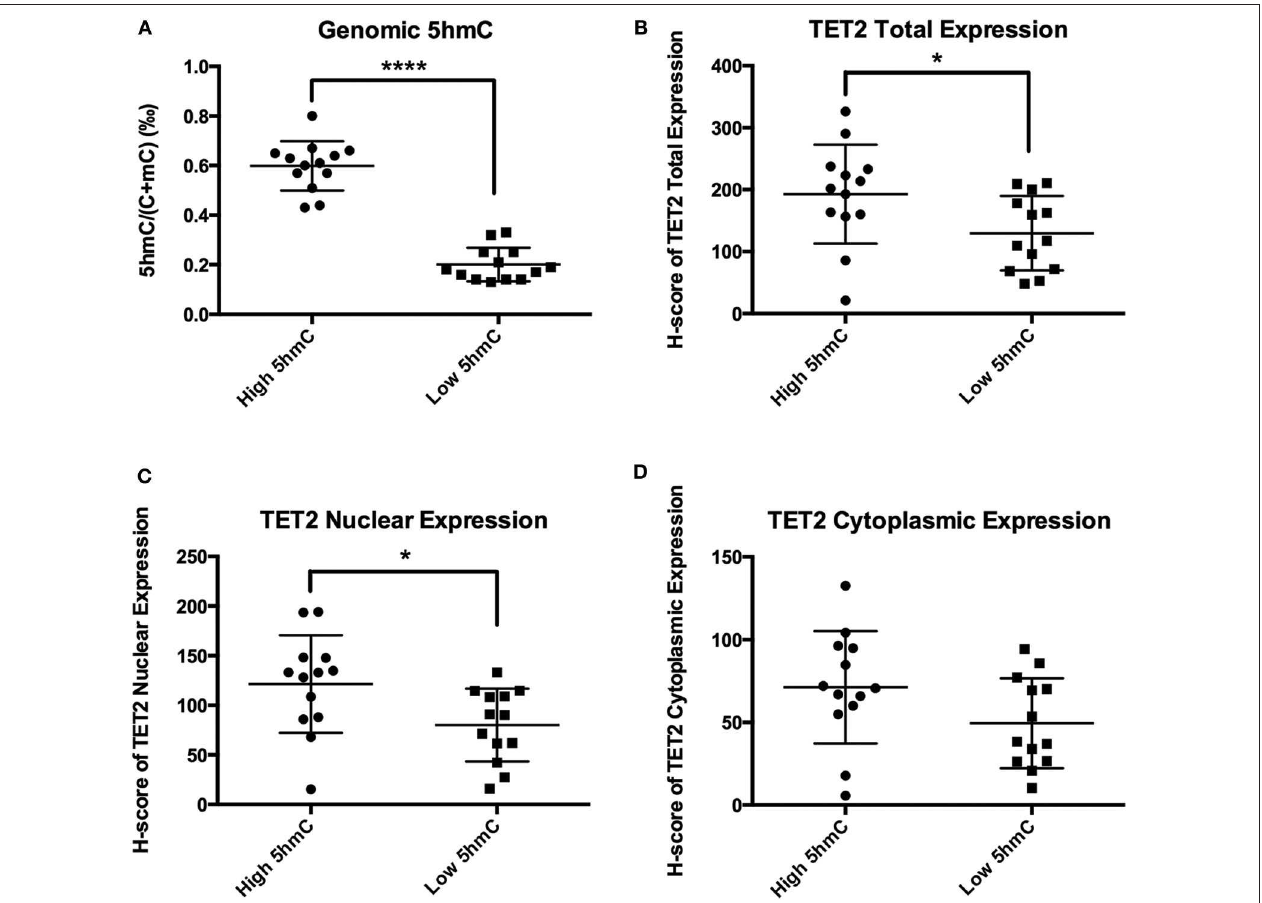
FIGURE 5 | TET2 expression and localization in high and low 5hmC groups. * P < 0.05; **** P < 0.0001. (A) There were significantly different of 5hmC levels between the low 5hmC group and the high 5hmC group. (B) TET2 total expression in the low 5hmC group was lower than that in the high 5hmC group. (C) TET2 nuclear expression in the low 5hmC group was lower than that in the high 5hmC group. (D) There was no significant difference in TET2 cytoplasmic localization between the low 5hmC group and the high 5hmC